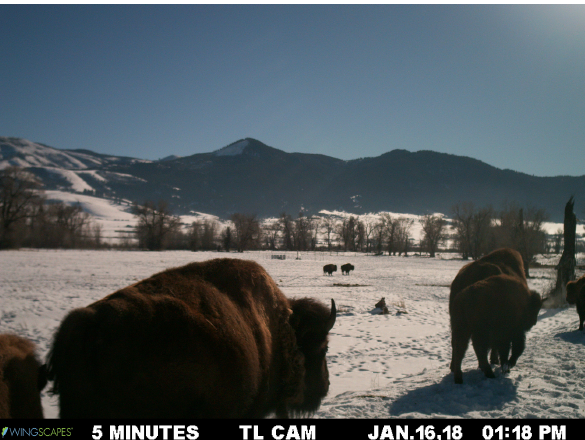
Figure 2. A sample image of bison as viewed from the south-facing time-lapse camera located to the north of the study area (Fig. 1). The eddy covariance installation is visible toward the center of the study site. Please note that the date format in this figure is month day year (mm dd, yy) and that the time format uses the 12h clock (AM and